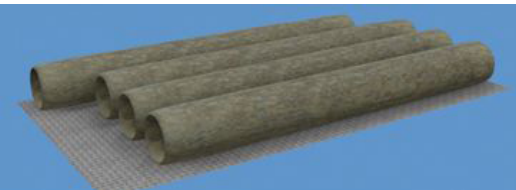
Figure 3. NCI in cylindric shape.